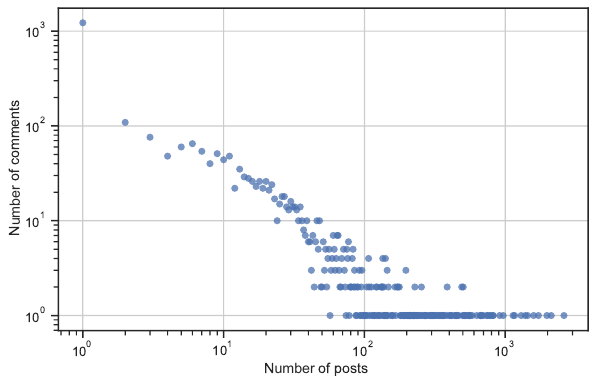
Figure 1. Distribution of comments against posts (log-log scale).